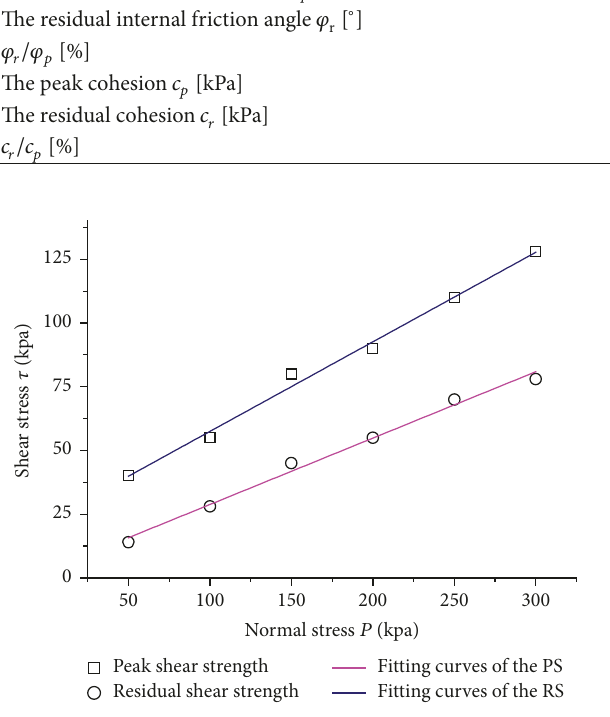
Figure 16: The peak shear strength (PS) 𝜏 𝑝 and the residual shear strength (RS) 𝜏 𝑟 as functions of the normal